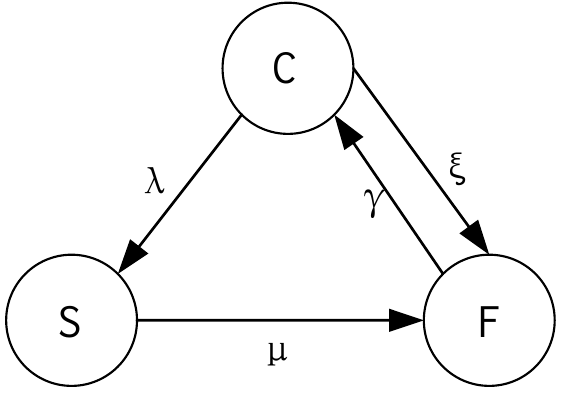
Figure 2. The state transfer among different states of a single